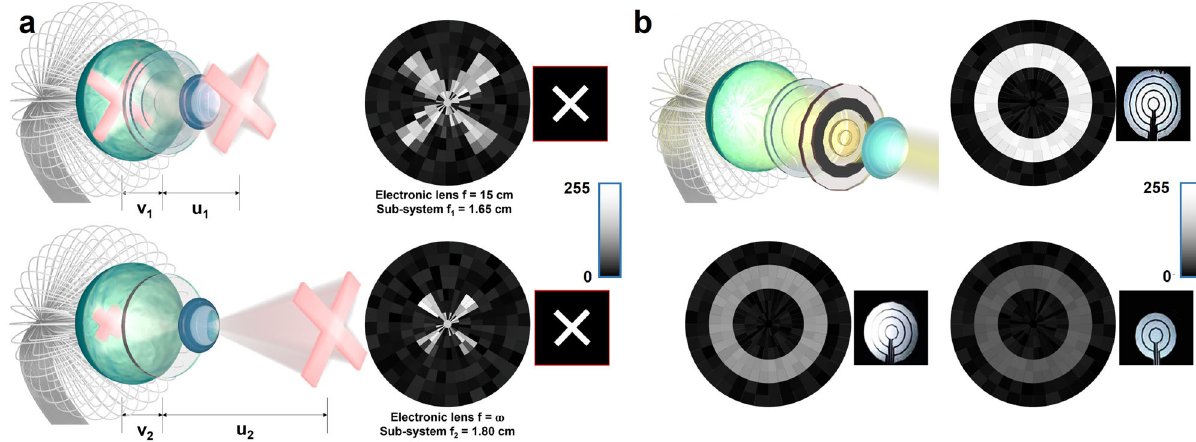
Fig.5|Imagingdemonstrationalongwithadaptiveoptics.a Theschematicsand corresponding image detected by the retina under 0V bias with different focal length controlled by electronics lens. b The schematic of assembled bionic